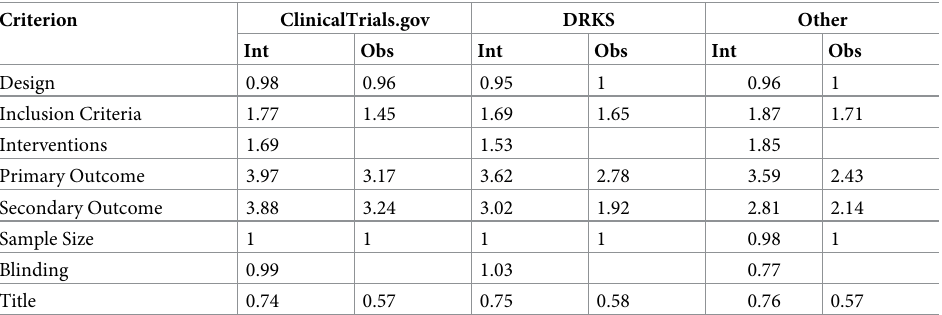
Table 5. Mean quality ratings in Clinicaltrials.gov, DRKS, and other registries, grouped by study type (Int: Inter- ventional, Obs: